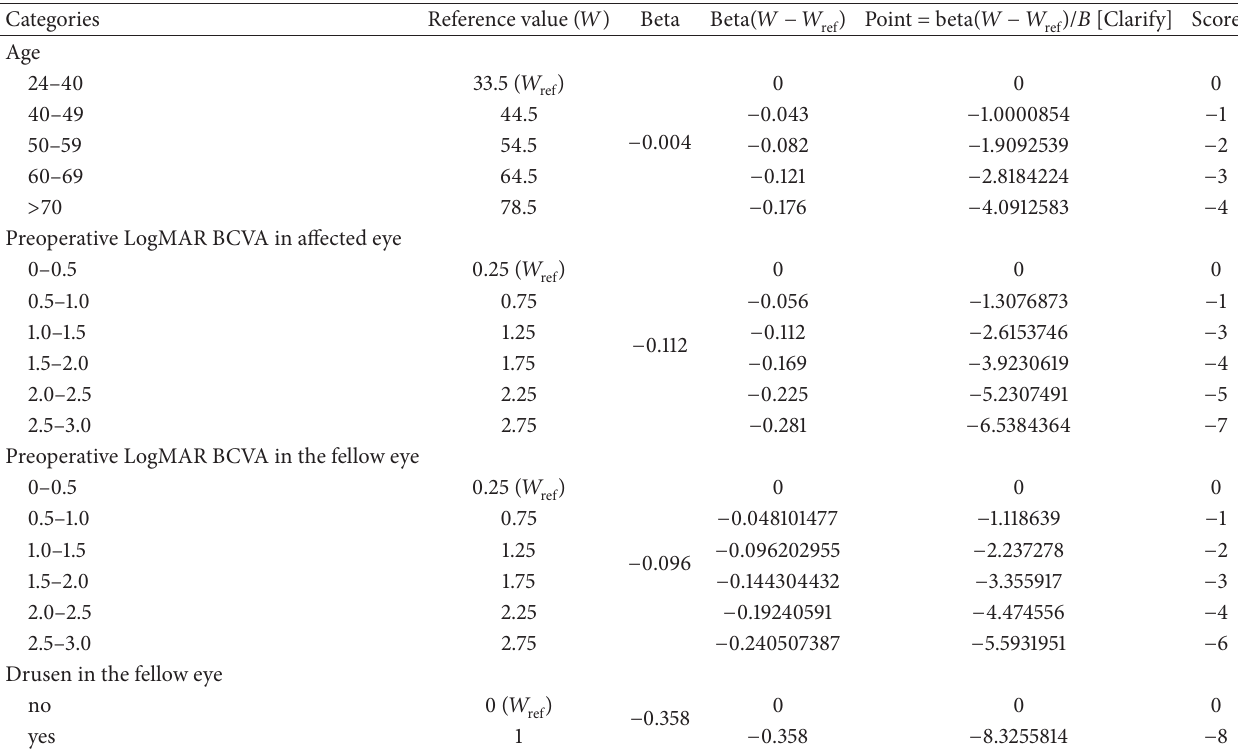
Table 4: Risk scoring system used to predict poor visual outcomes after vitrectomy in patients with acute-onset vitreous hemorrhage (VH) of preoperatively unknown